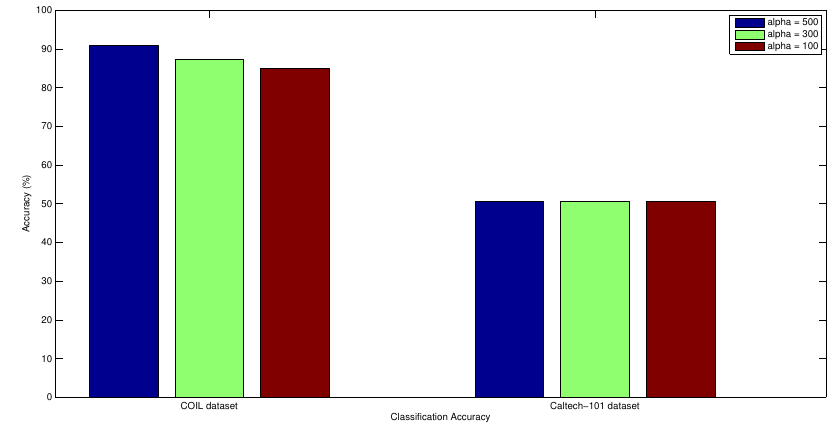
Figure 14. Average accuracy over COIL and Caltech-101 datasets using different values of parameter α